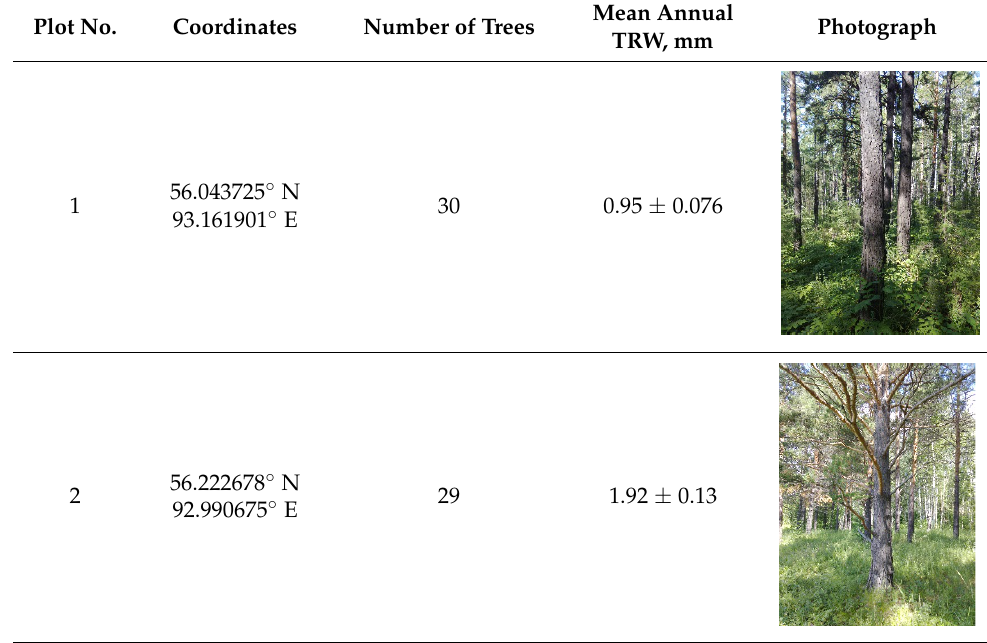
Table 1. Coordinates of sample plots and characterization of tree stands. Plot No.